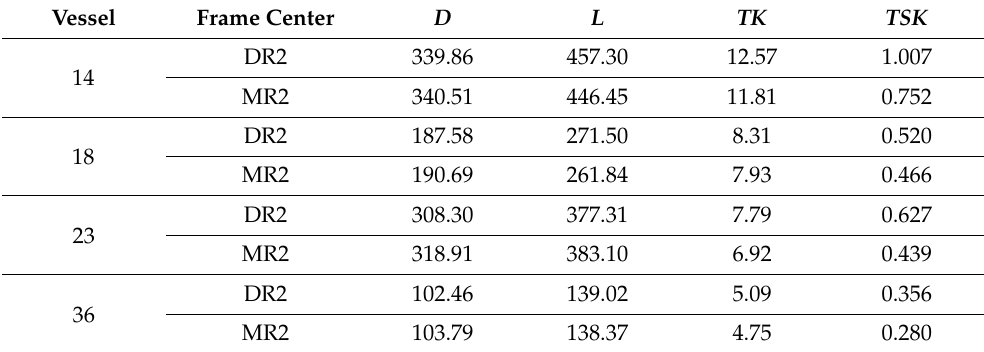
Figure 9. Pairs of vessel segments. Point 14 is vessel 4 in ML1/DL1, point 18 is vessel 8 in ML1/DL1, point 23 is vessel 3 in MR2/DR2 (see Figure 6), and point 36 is vessel 6 in ML2/DL2). They fall off the limits of concordance in some Bland – Altman plots (Figure 8). Magenta (cyan) lines correspond to M-retinography (D-retinography). Table 6. Geometrical features of the vessels in Figure 9.